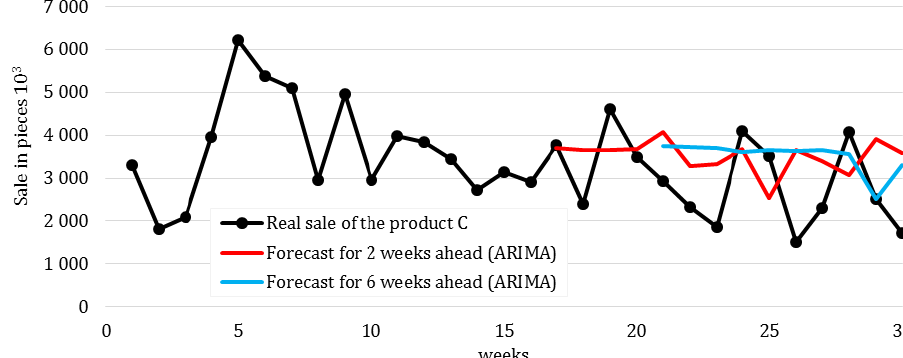
Figure 4: Real sale of the product C and forecasts by